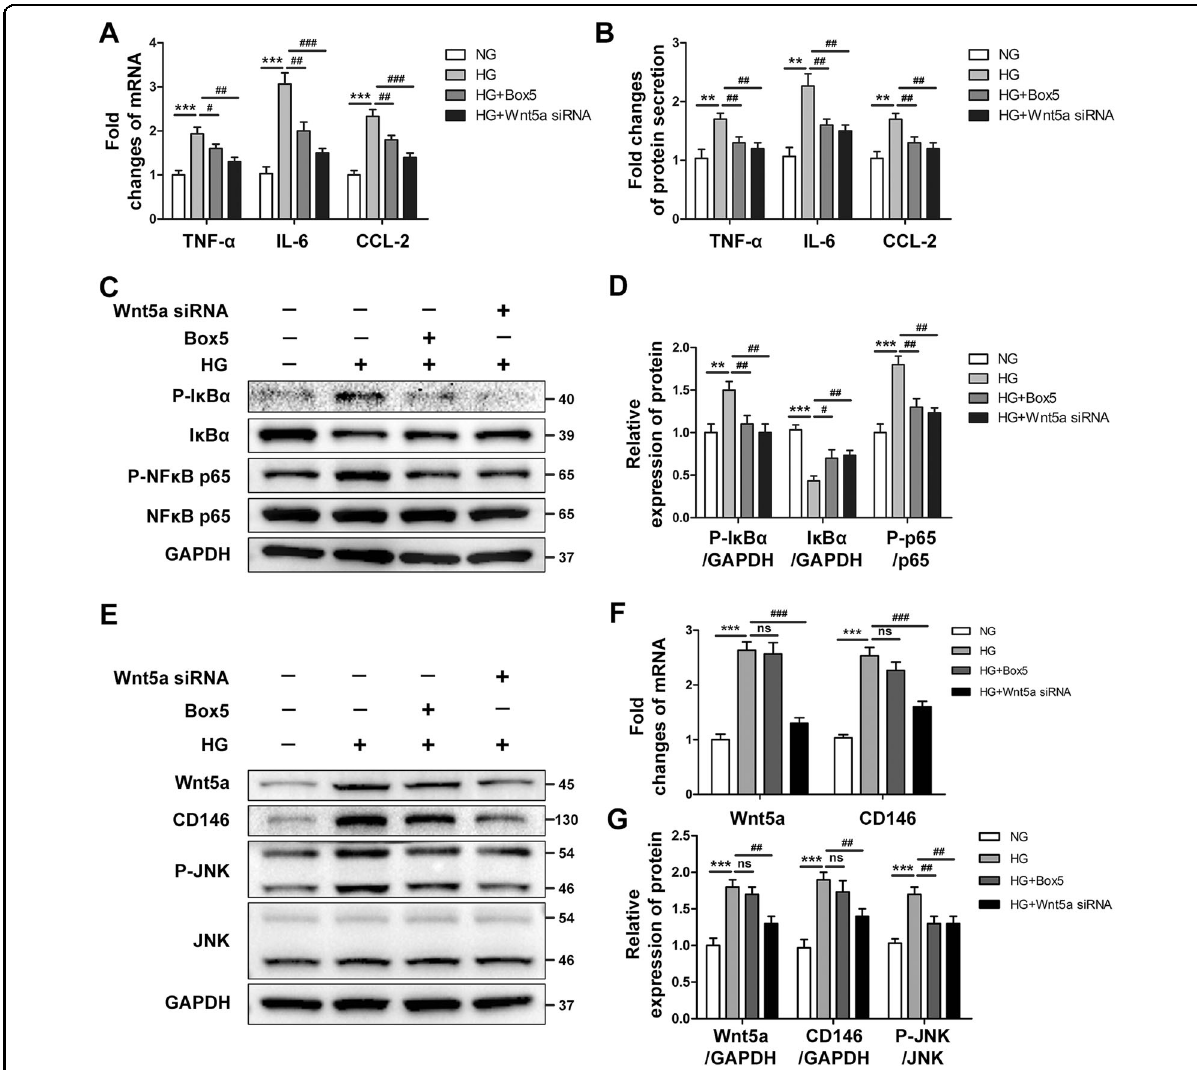
HK-2 cells were transfected with 50 nM Wnt5a siRNA or pretreated with Box5 (100 μ M/L) before exposure to high glucose (HG, 30 mM) for 24 h. The control group was incubated with normal glucose (NG, 5.5 mM). The mRNA expression of TNF- α , IL-6, and CCL-2 was determined by real-time PCR. *** P < 0.001 versus NG group, ### P < 0.001, ## P < 0.01, # P < 0.05 versus HG group. B The protein synthesis of TNF- α , IL-6, and CCL-2 in